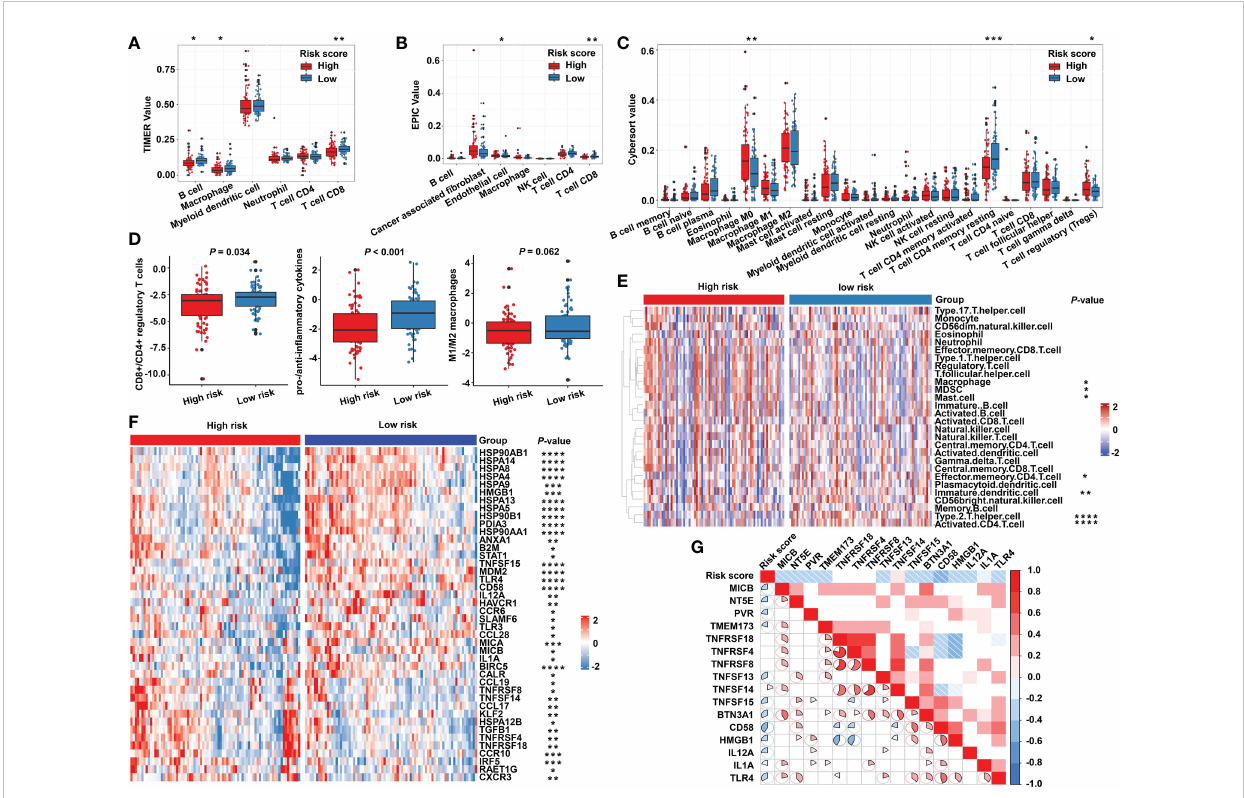
FIGURE 6 The immune characteristics of the m 5 C regulator – based signature in READ. The deconvolution algorithms of TIMER (A) , EPIC (B) , and CIBERSORT (C) , which were applied to estimate the immune in fi ltration status between the high- and low-risk groups. (D) The ratios of CD8+ T cells to CD4+ regulatory T cells, pro- to anti-in fl ammatory cytokines, and M1 to M2 macrophages in the TCGA dataset. (E) GSVA analysis based on GO terms for the high- and low-risk groups. (F) The heat map depicts the expression of positive genes collected from cancer – immunity cycle based on the TCGA cohort. (G) Pearson correlation among immune stimulators was conducted and is shown in a correlation heat map. Correlations with P value > 0.05 are blank. **** P < 0.0001; *** P < 0.001; ** P < 0.01; * P <